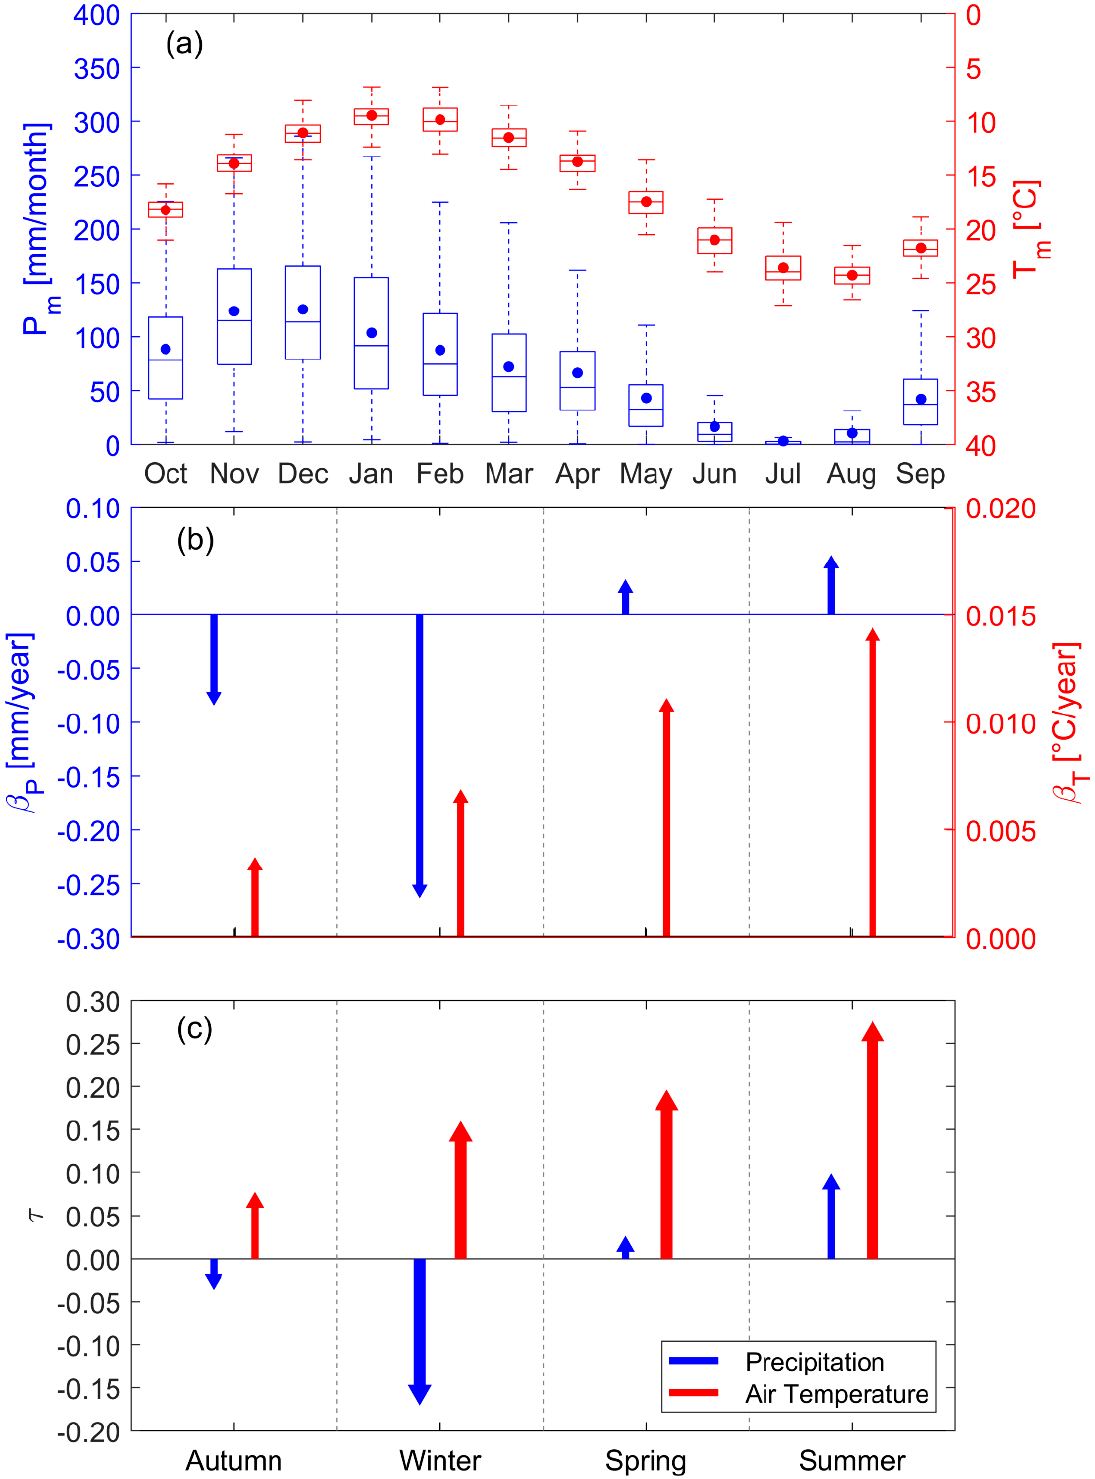
Figure 5. Historical climate at the Fluminimaggiore basin: ( a ) monthly precipitation (P m ) and air temperature (T m ) regimes (in each estimation box, the statistics of the 1924 − 2021 period are shown: filled circles indicate the means, the horizontal lines the median, the box and whiskers represent quartiles, and outliers are depicted individually); ( b ) the Theil − Sen β of the seasonal mean precipitation and air temperature trends; ( c ) the Mann − Kendall τ of the seasonal mean precipitation and air temperature trends (thicker arrows when p < 0.05).